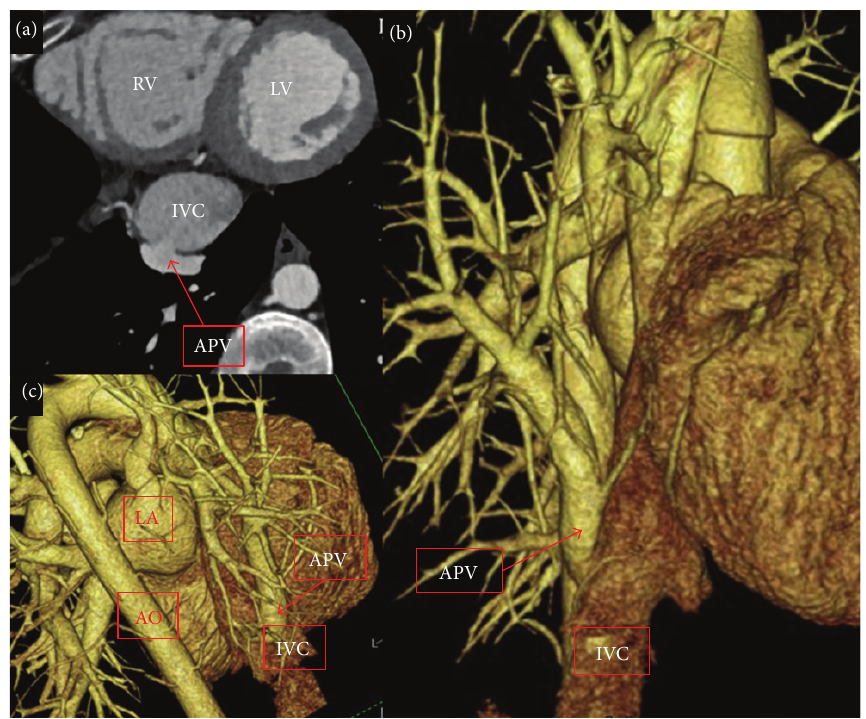
Figure 1: Axial and coronal images with sequential gating; cardiac phases utilized of 40–80% on CCTA (kVp = 120 with care dose variable mAs and slice thickness of 0.7 mm with 0.4 overlap). They revealed the presence of an anomalous pulmonary venous connection between the right lower lobe pulmonary vein (APV) and the enlarged inferior vena cava (IVC) [a, b, and c].